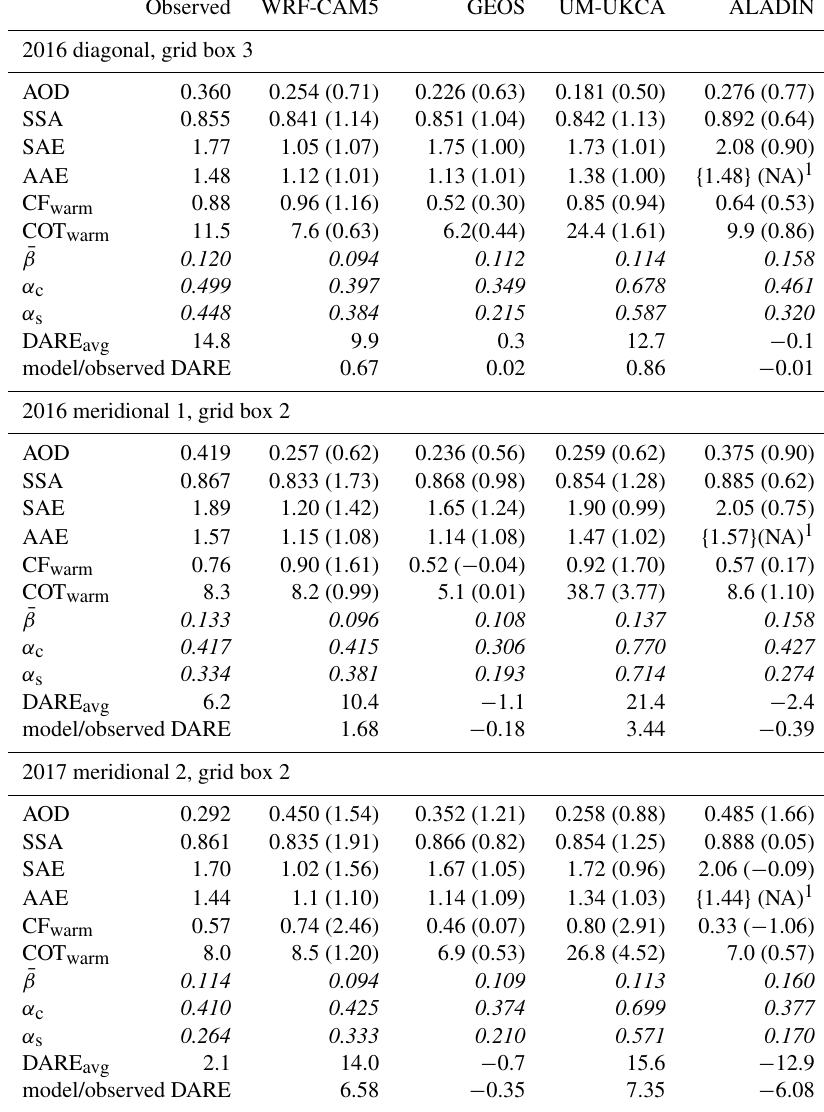
Table 3. TOA DARE avg (in watts per square meter) calculated using Eq. (4) and the grid box mean observed and modeled aerosol and cloud properties used in the calculation for select comparison grid boxes. Also given in parentheses after each modeled variable is the ratio of DARE avg calculated using that model’s value for the given variable only and the observed values for all other variables to DARE avg calculated using the observed variables. The values of ¯ β , α c , and α s are shown in italics because they are derived from the observed and modeled parameters (see the text). In the table below, α s = 0 . 07(1 − CF warm ) + α c CF warm is given as a metric for the combined effect of CF warm and COT warm on DARE. As noted in the text, DARE is actually calculated separately for clear and cloudy skies using Eq. (3), then DARE avg is calculated using Eq.